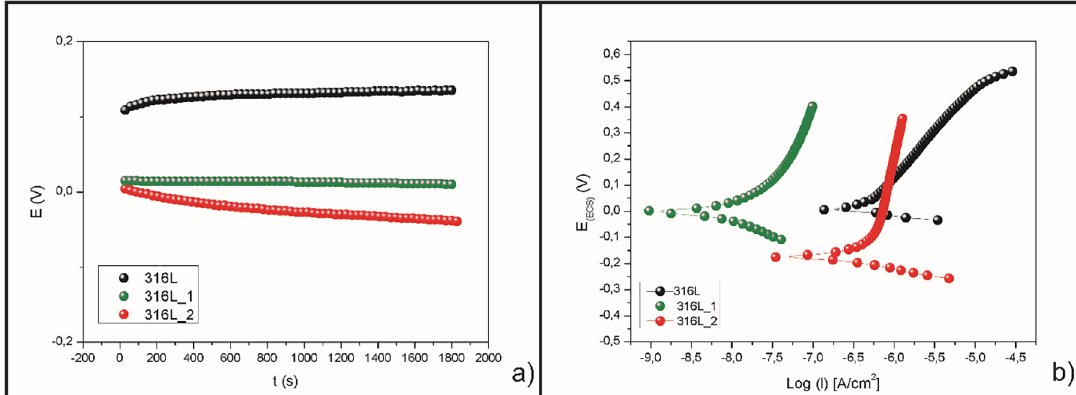
Figure 6. (a) OCP monitoring and (b) polarization curves for the studied samples in SBF solution.